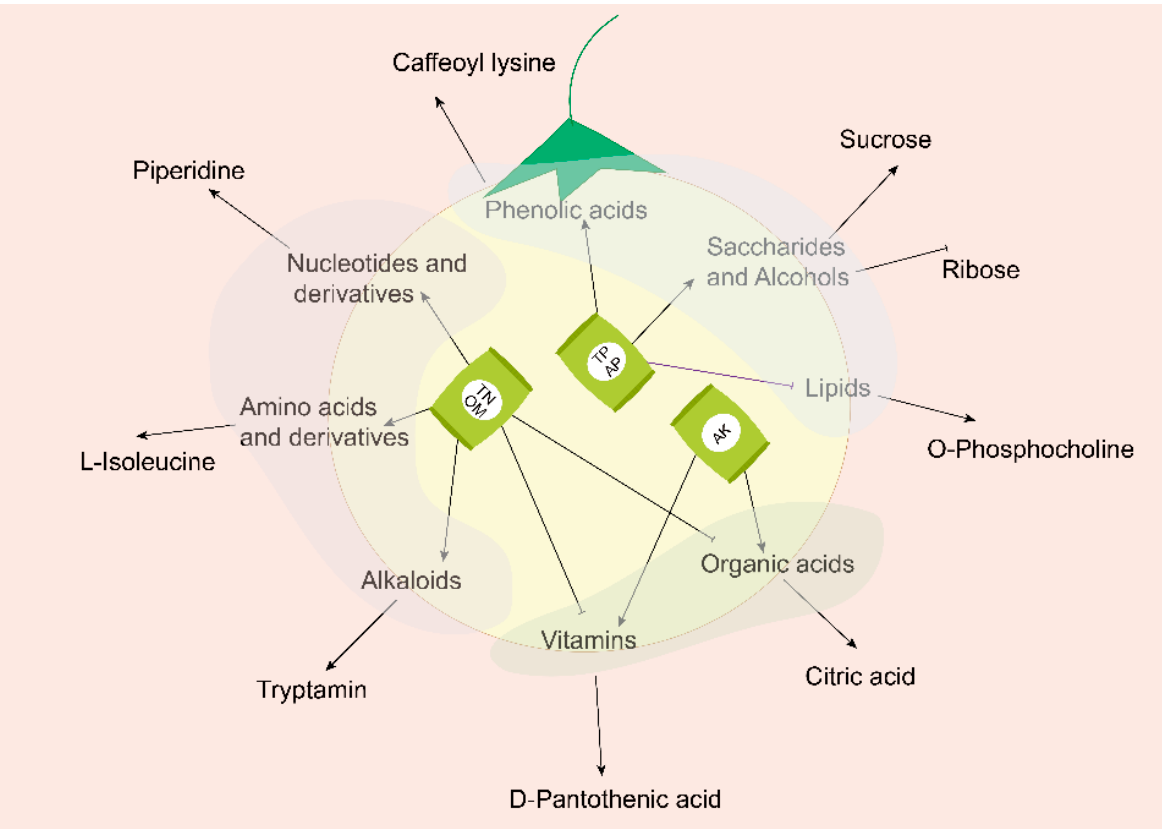
Figure 10. Effect of soil nutrients on pepino metabolic compounds.